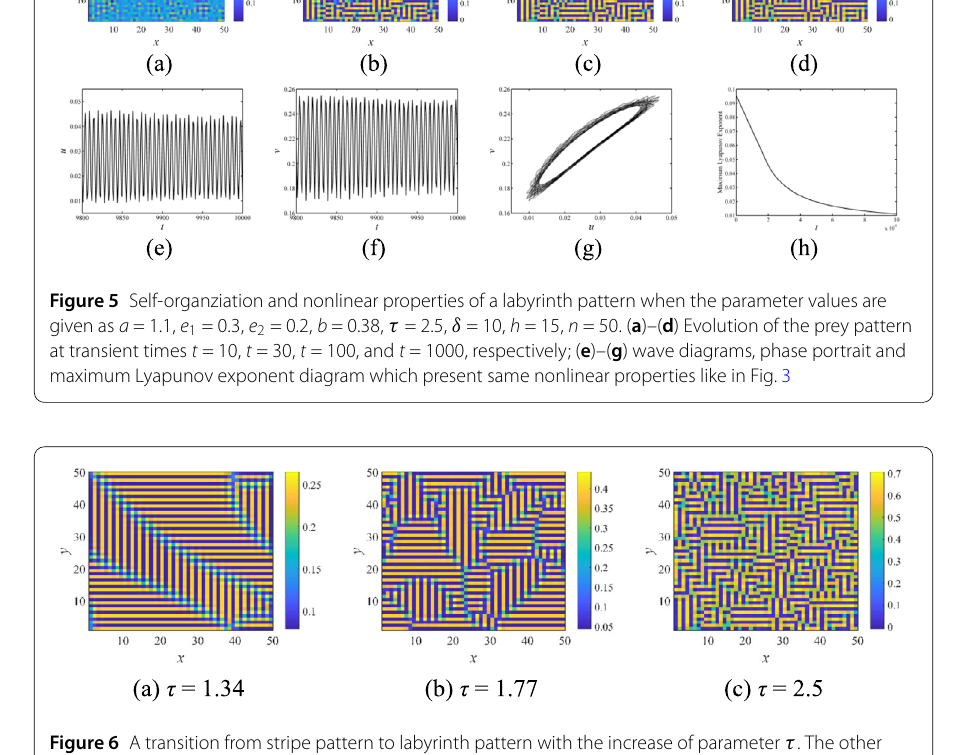
Figure 6 A transition from stripe pattern to labyrinth pattern with the increase of parameter τ . The other parameter values are given as a = 1.1, e 1 = 0.3, e 2 = 0.2, b = 0.38, δ = 10, h = 15, n =